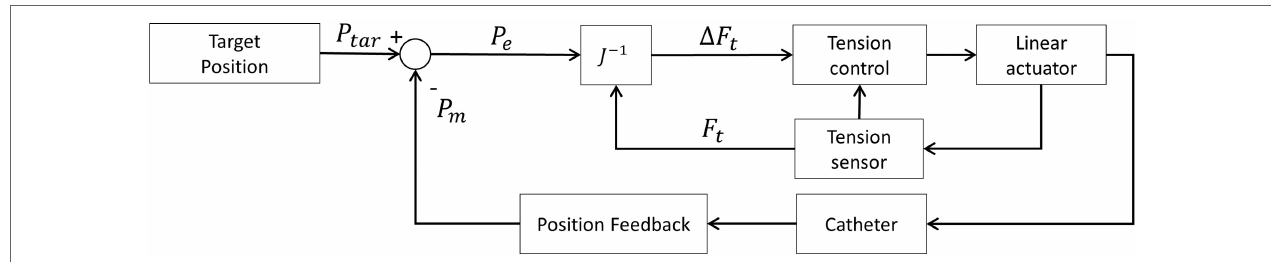
FigUre 11 | inverse Jacobian method for catheter tip position control—schematic diagram